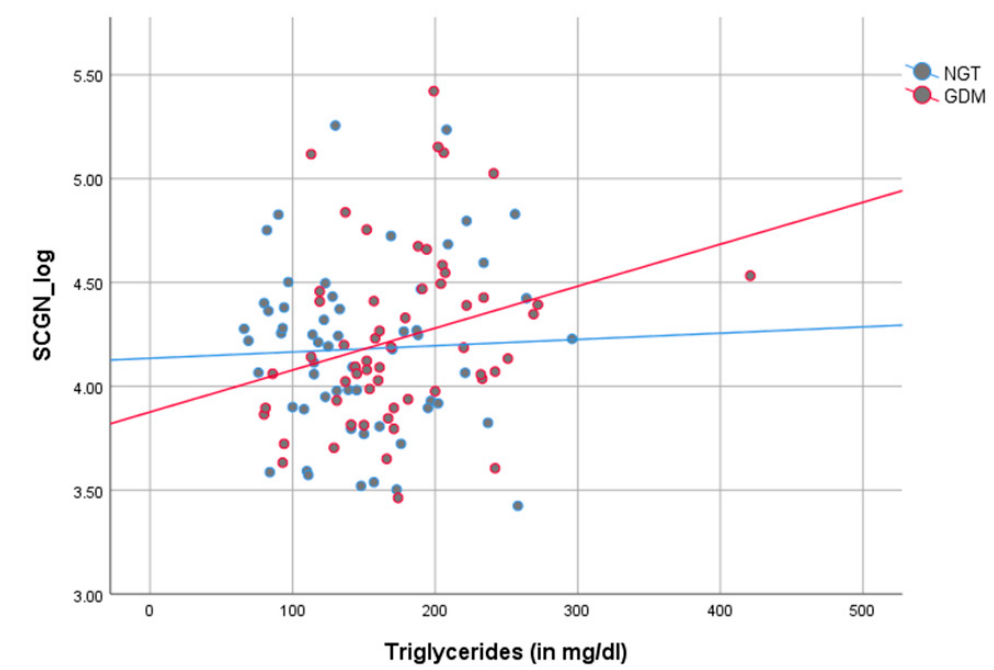
Figure 3. Grouped scatter dot plot according to glucose tolerance (blue = NGT, red = GDM) of the correlation between secretagogin (SCGN) (log-transformed) triglycerides during pregnancy. SCGN correlated positively with triglycerides (TG) in women with GDM ( r p = 0.276, p = 0.038). In NGT, a similar trend, albeit not significant, is visible ( r p = 0.041, p = 0.761). NGT: normal glucose tolerance; GDM: gestational diabetes mellitus; TG: triglycerides. SCGN levels increased marginally during pregnancy; SCGN levels correlated positively with GW in women with GDM ( r p = 0.308, p = 0.021); in NGT, the correlation was not significant (see Figure 4 and Table